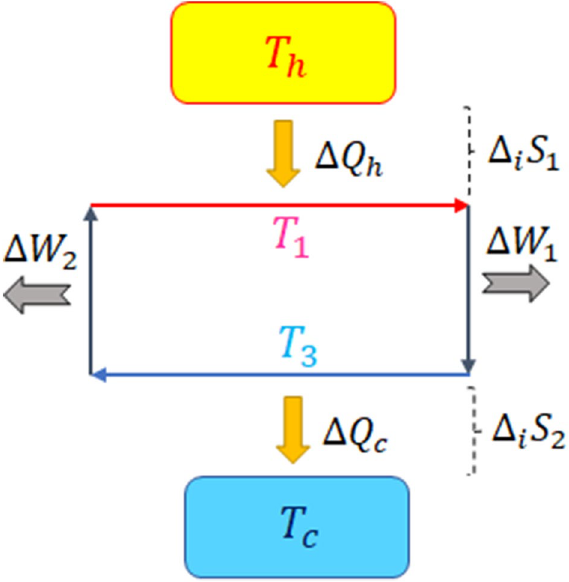
Figure 1. A classical engine working between two reservoirs at temperatures T h > T c . Irreversibility occurs between the engine and the reservoirs not in the interior of the